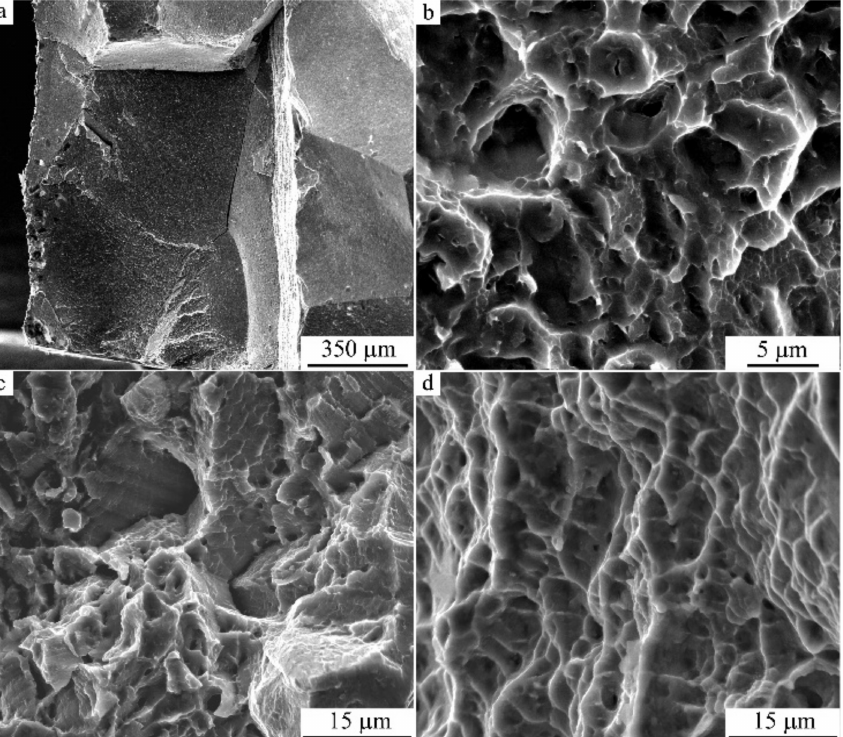
Figure 19. ( a – d ) SEM images of fracture surfaces of the specimens of Cu-14Al-3Ni alloy after ( a ) hot- forging and quenching (HFQ); ( b ) HFQ + HPT, n = 10 revs; ( c ) double quenching (DQ), with second Q from 1273 K; and ( d ) DQ + HPT, n = 10 revs + uniaxial tensile treatment at 423